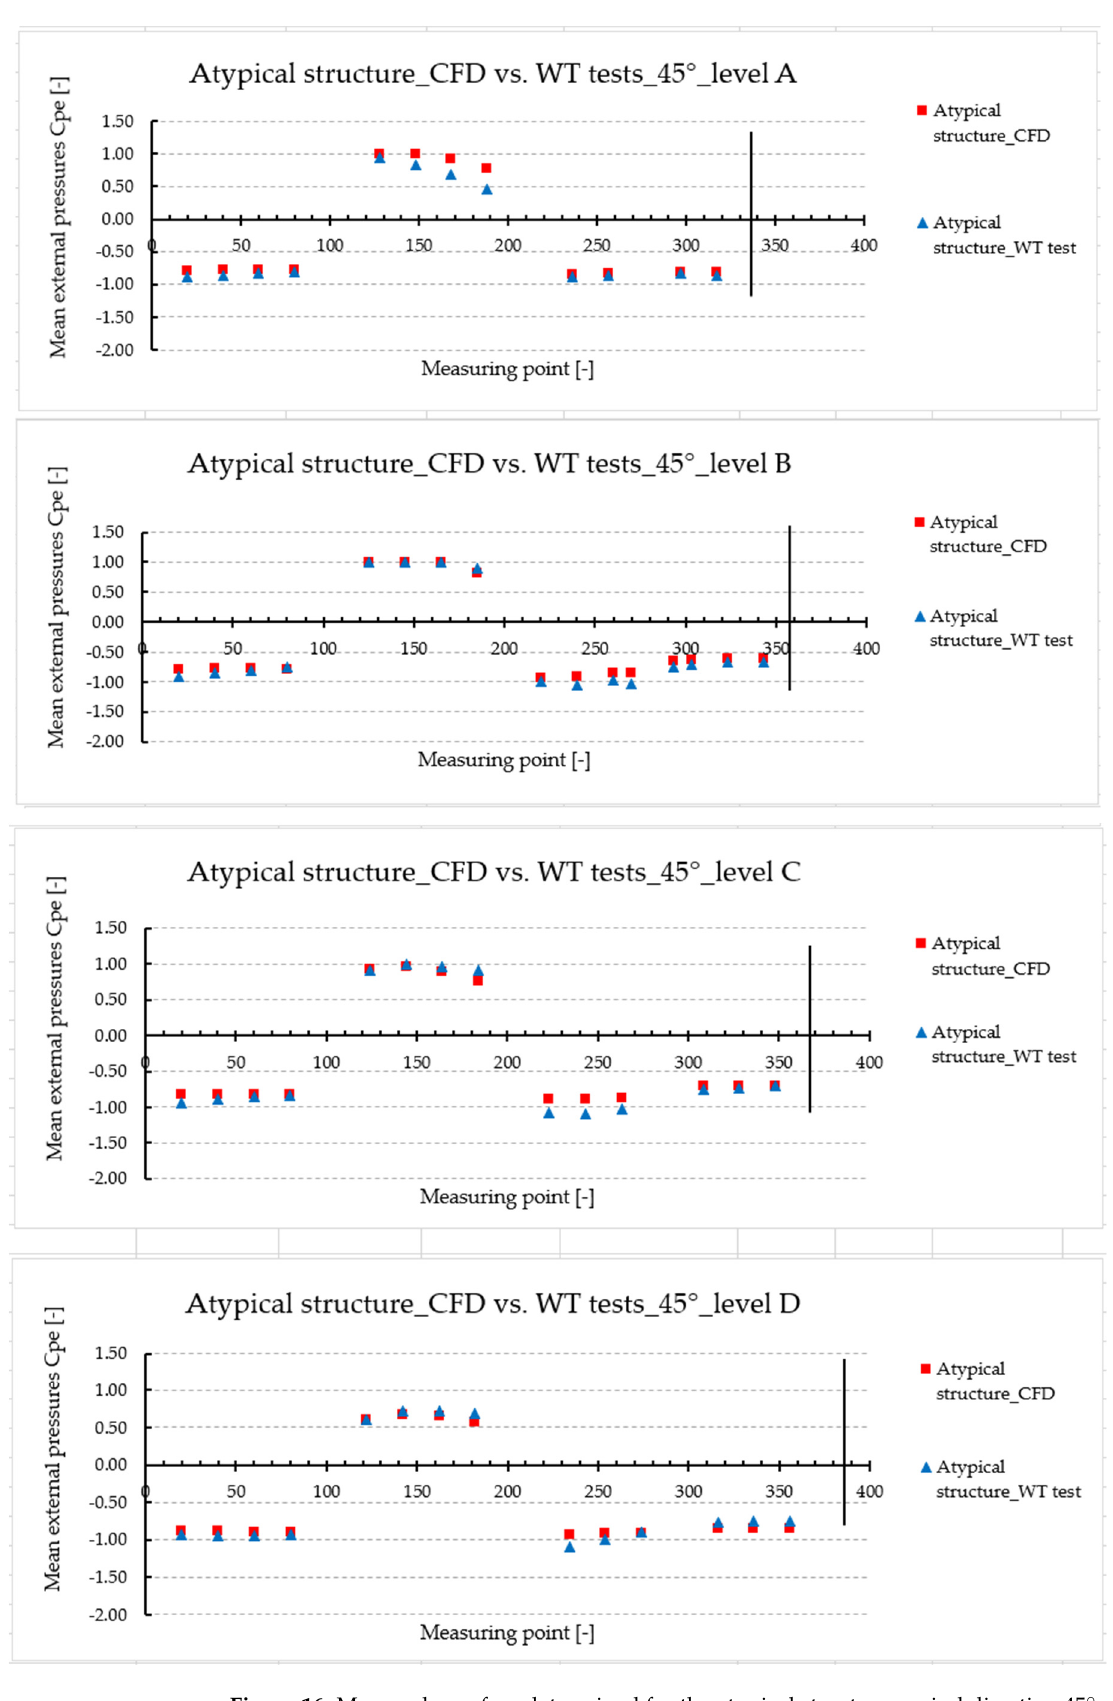
Figure 16. Mean values of c pe determined for the atypical structure—wind direction 45°.